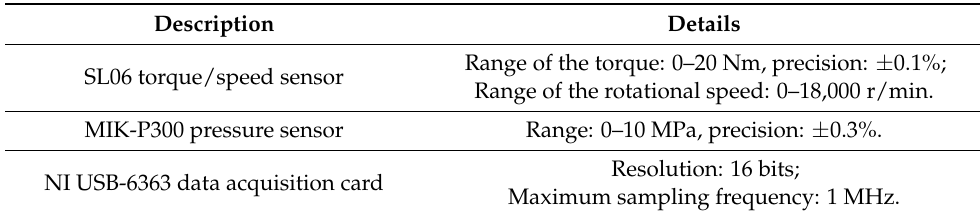
Figure 17. Schematic diagram of the experiment rig. Table 2. Details of the relevant